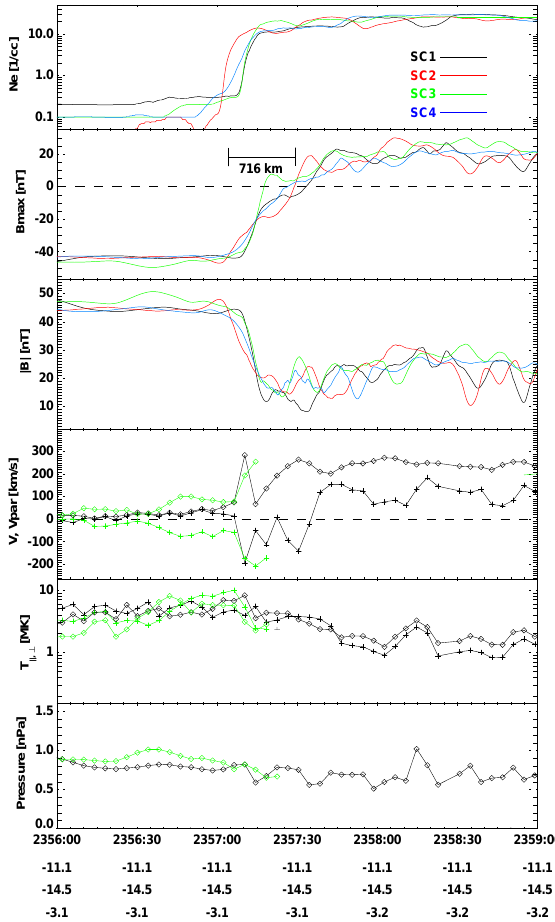
Fig. 4. Plasma and magnetic field data for the outbound crossing near 23:57 UT on 4 July 2001. From top to bottom, the panels are: plasma density (from EFW), maximum variance component and magnitude of the magnetic field (from FGM) for all four Clus- ter spacecraft, plotted as 6-s running averages with 0.2-s spacing; magnitude (diamonds) and parallel component (plus symbols) of the ion bulk velocities; parallel (plus symbols) and perpendicular (diamonds) ion temperatures; total pressure (plasma plus magnetic), all from CIS-HIA on spacecraft C1 and C3, plotted at spin resolu- tion ( ∼ 4s). There is a data gap in the C3 plasma data right after the magnetopause transition. The magnetopause thickness from C1, calculated as described in Sect. 3.2, was 716km for this case, and is shown as a horizontal bar in the B max panel. The time axis ap- plies to the C1 measurements. The C2, C3, and C4 data have been shifted and stretched, in order to line up the crossings and turn them into spatial profiles, as described in the text. The position of C1 (in GSE coordinates) is given along the UT axis. Note the sharp rise in density at the inner edge of the magnetopause current